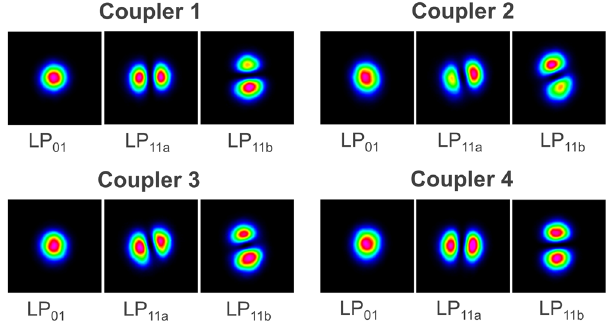
Figure 3. Mode intensity profiles. The LP 01 , LP 11a and LP 11b modes at 1550 nm imaged at the output ports of the FM-MCF multiplexer.